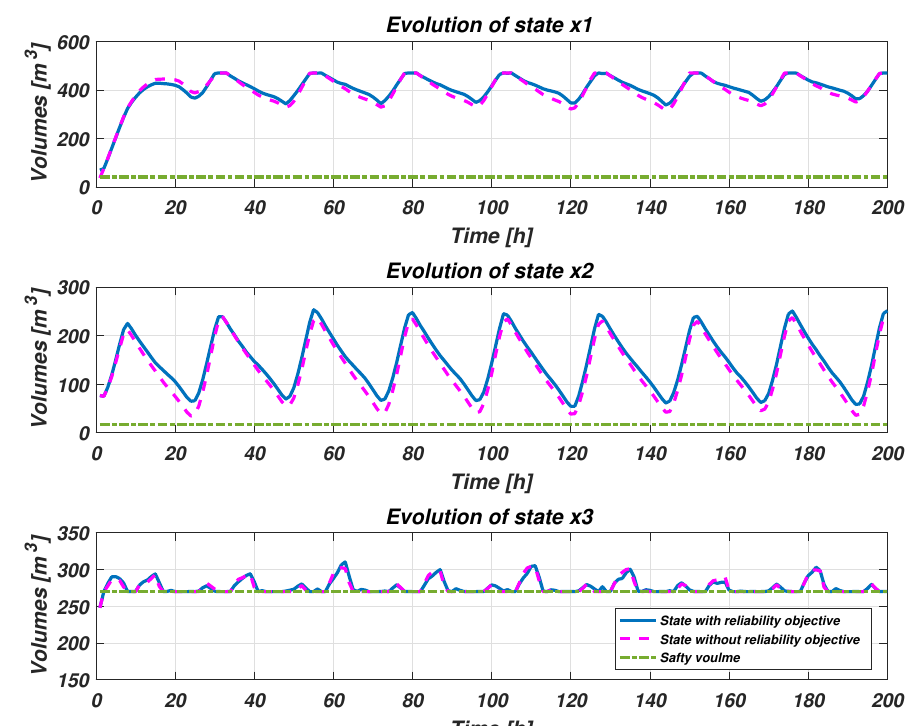
Figure 5. Results of the evolutions of storage tanks for three